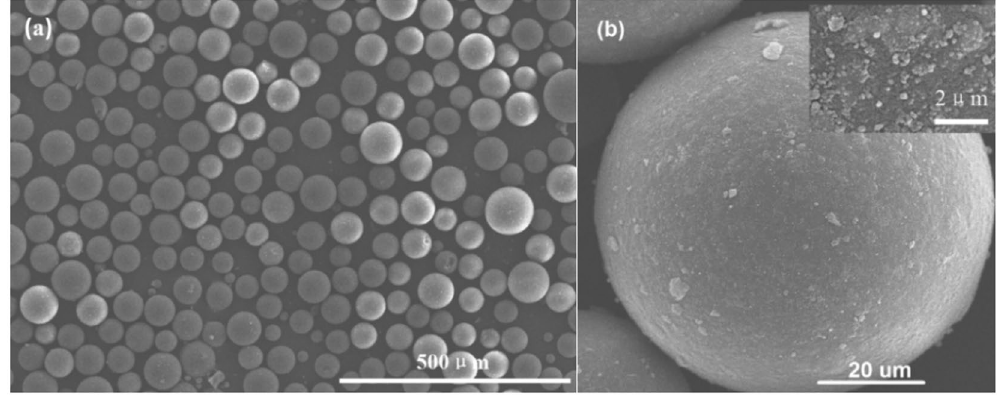
Figure 3. ( a ) Low magnification and ( b ) high magnification SEM images for